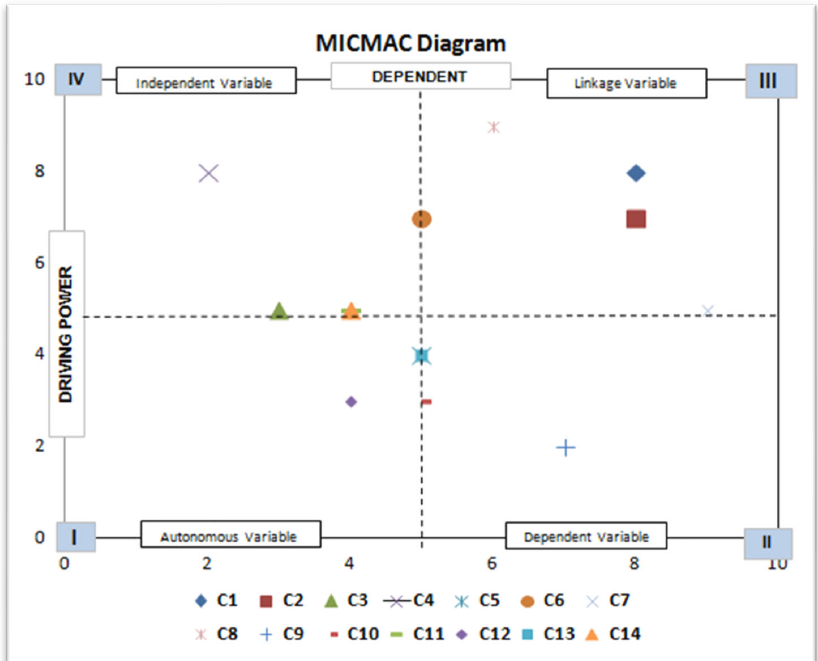
Fig. 5. Diagram of MICMAC Analysis of the Social Vulnerability of the Development of Islamic State